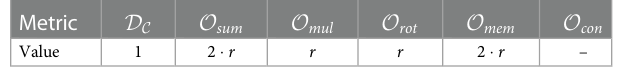
TABLE 1 Ef fi ciency analysis of Rotation of a big cleartext vector when it is packed over multiple ciphertexts ( Algorithm 10). Metric